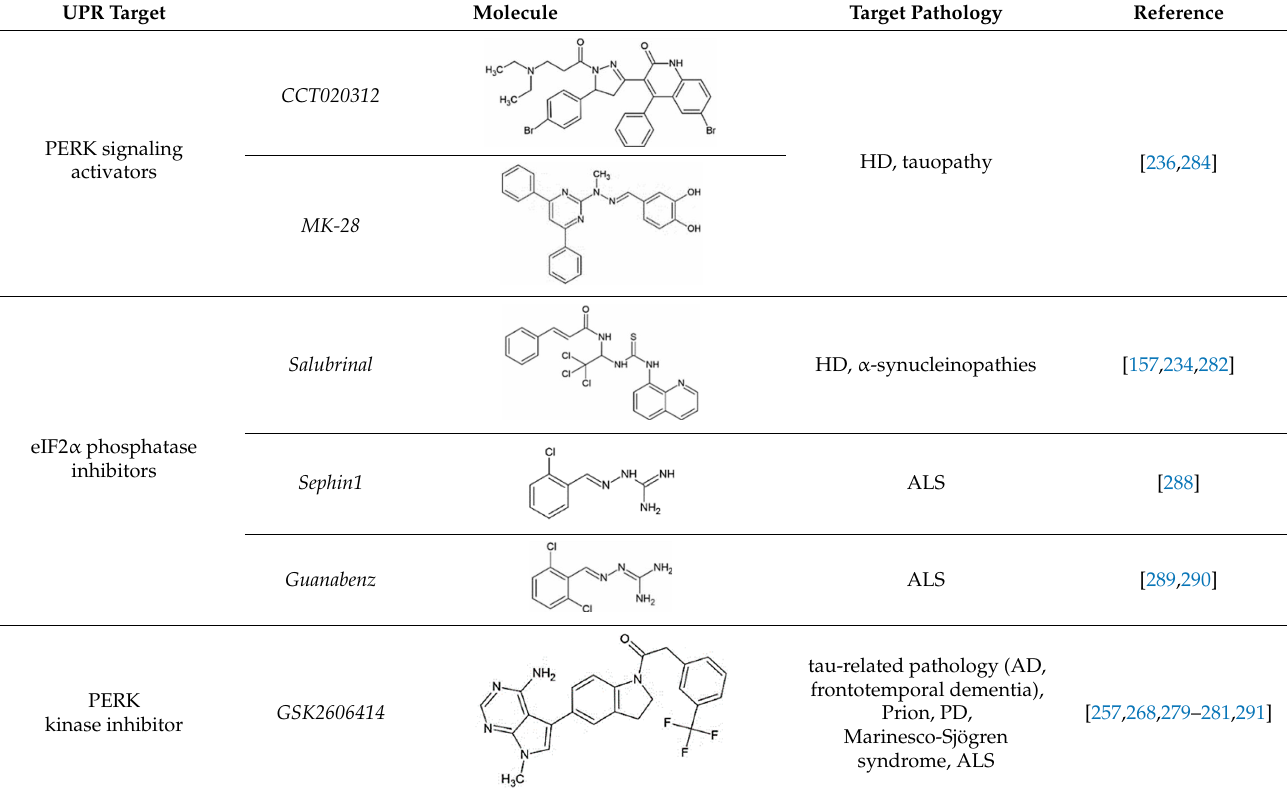
Table 2. UPR component targeting molecules and their reported efficacy on protein aggregates-related neurological pathology.